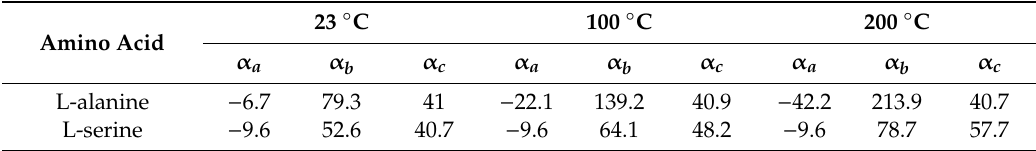
Table 2. Thermal expansion coefficients ( α × 10 − 6 °C − 1 ) of the L-ala and L-ser orthorhombic crystal structures along the axes of the thermal deformation tensor: α 11 = α a , α 22 = α b , and α 33 = α c .